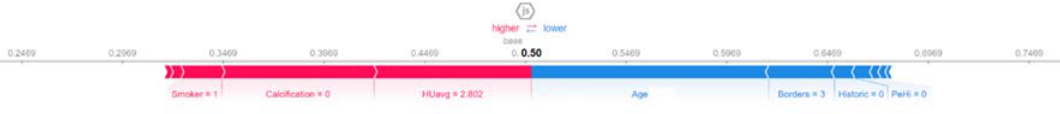
Figure 9. Shap explainability representation for the case study.